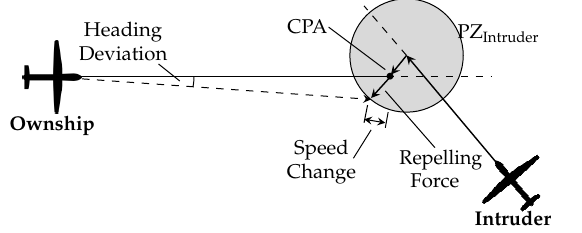
Figure 8. Modified voltage potential (MVP) geometric resolution. Adapted from